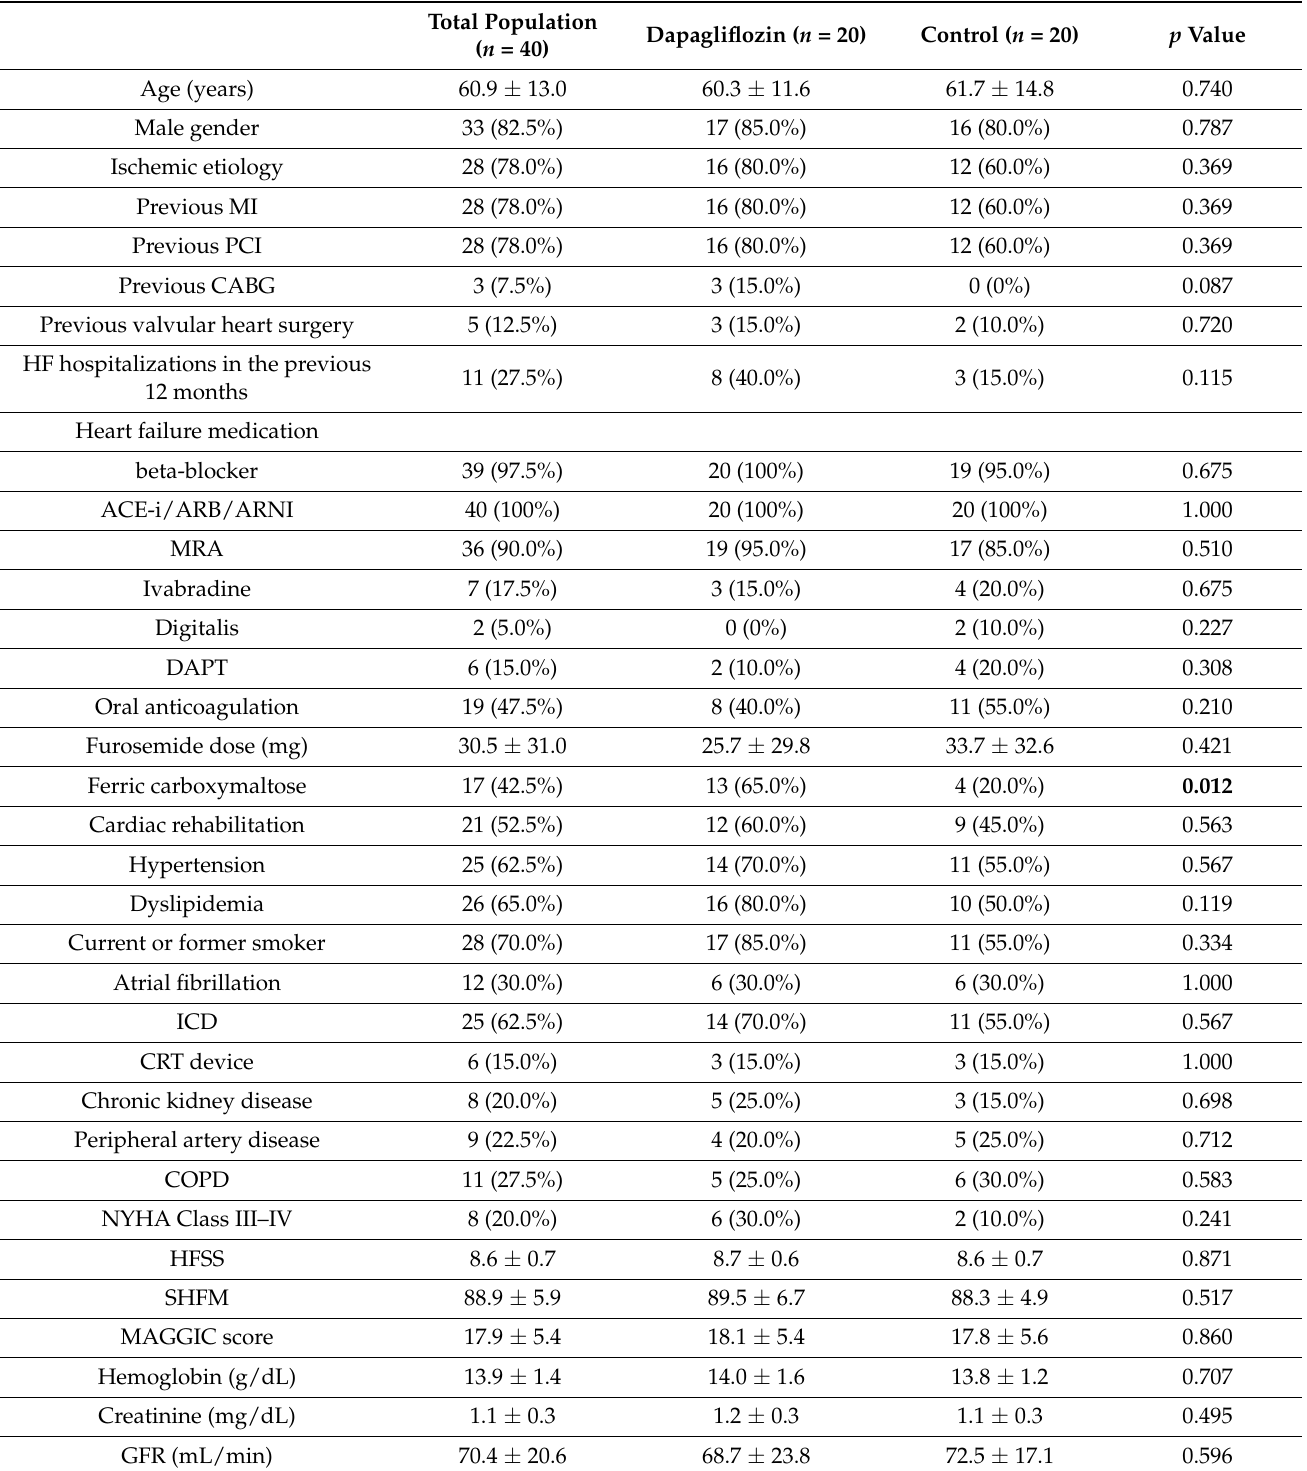
Table 1. Comparison of the baseline clinical characteristics between the two